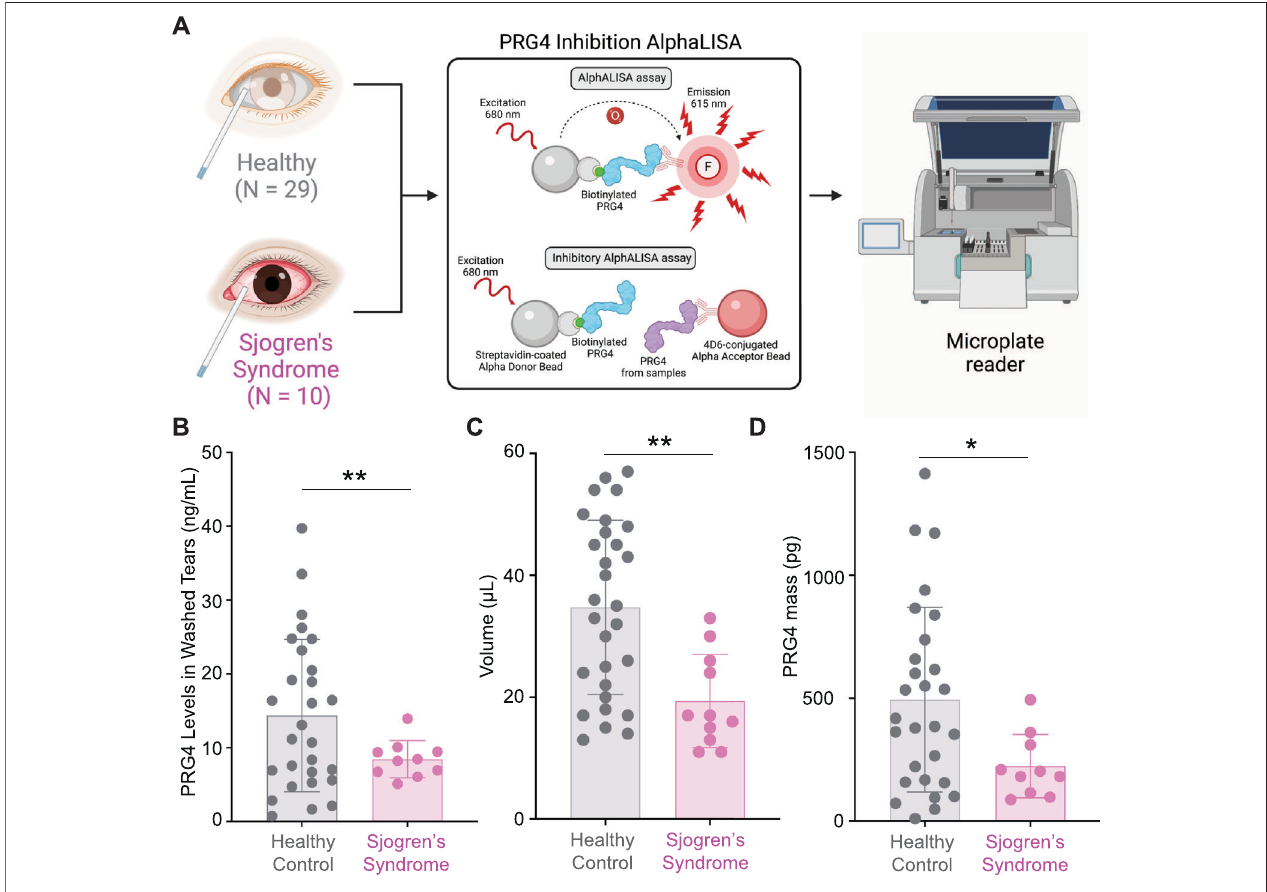
FIGURE3| MeasurementsofPRG4inTearWashes. (A) AlphALISAwork fl owusingadesignedPRG4antibody4D6-basedassay. (B) PRG4levels, (C) volumeand (D) PRG4 mass were measured. Data are represented as bar graphs with ± standard deviation (SD) and analyzed by a Welch ’ s two-tailed paired t test: * p > 0.05, ** p > 0.01.